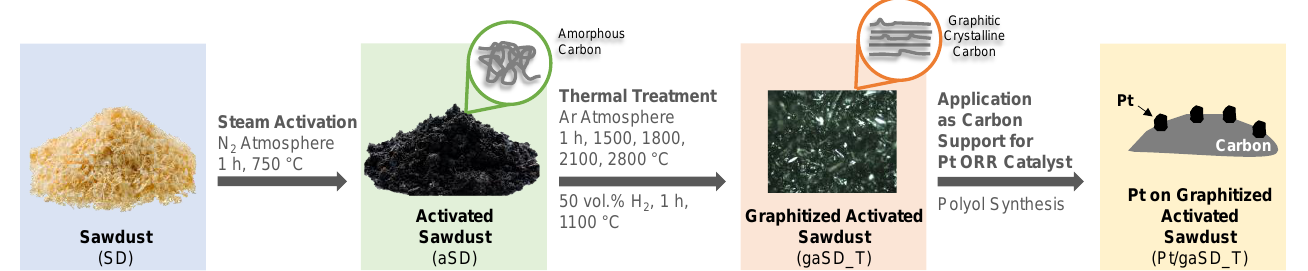
Figure 1. Schematic overview of the treatment of sawdust, the change in carbon structure and its use as a platinum ORR catalyst.